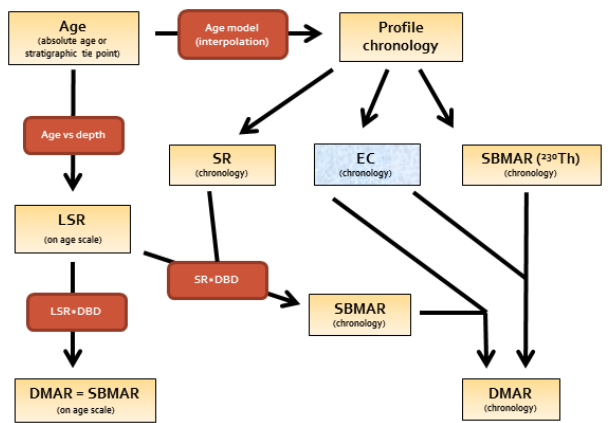
Figure 1. Schematic representation of the process of calculation of eolian DMAR (dust mass accumulation rate), and its relation to the SR (sedimentation rate), DBD (dry bulk density), SBMAR (sediment bulk MAR), and EC (eolian content). DMAR (on age scale) is the typical path for loess–paleosol records, whereas DMAR (chronology) indicates the final step of the workflow when EC is also